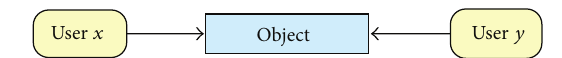
Figure 1: The object-based relationship in the social network on the